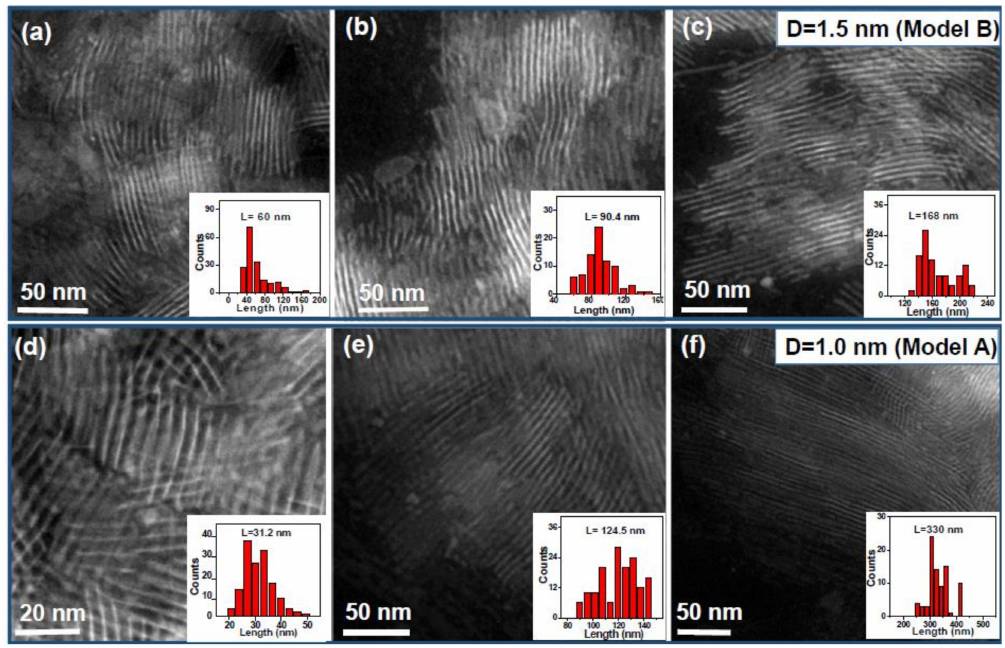
Figure 2. High angle annular dark field–scanning transmission electron microscopy (HAADF-STEM) images to show the length changes of ZnS USNWs of 1.5 nm (model B: a – c ) and 1.0 nm (model A: d – f ) diameter with reaction time: ( a ) reaction for 45 min; ( b ) reaction for 90 min, and ( c ) reaction for 180 min; ( d ) reaction for 25 min after the initial precursor injection, and reaction for another 30 min ( e ) and 90 min ( f ) after the third additional precursor injection. The insets in ( a – f ) are their corresponding length distribution